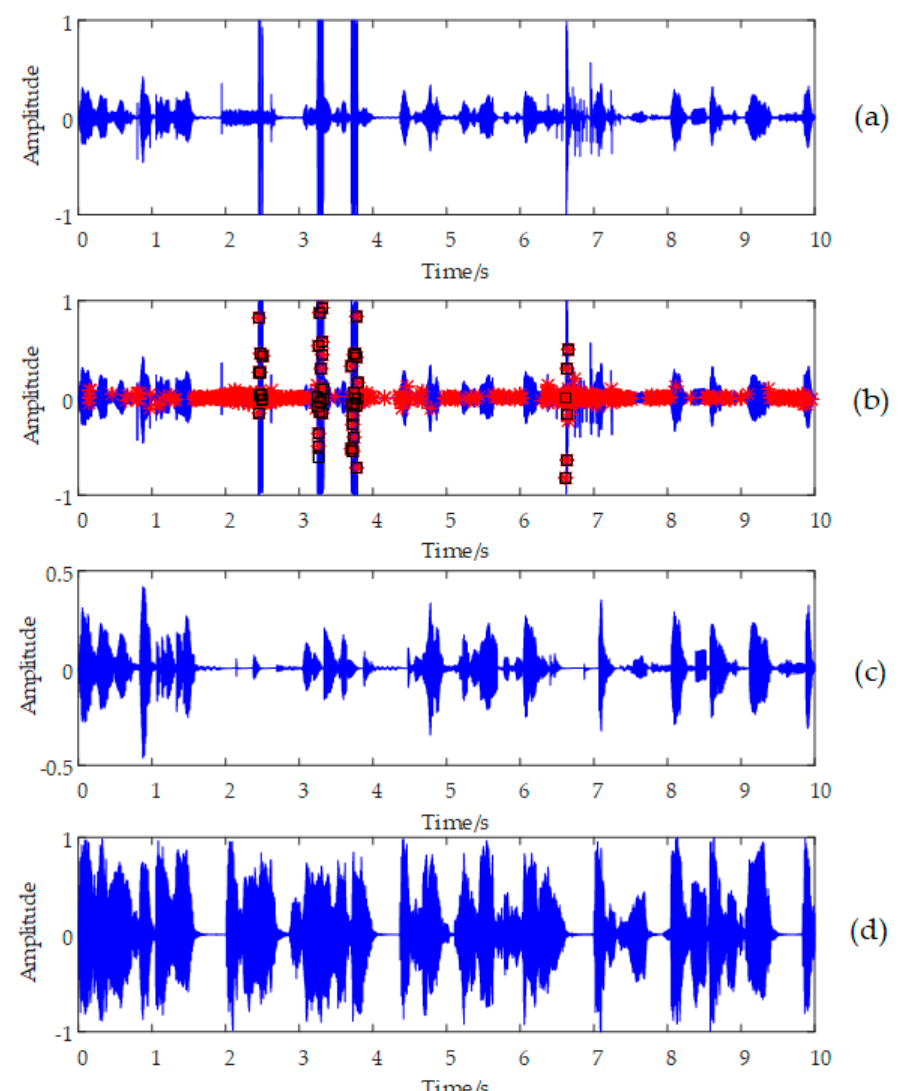
Figure 7. Laser captured speech signal showing ( a ) the raw-detected signal, ( b ) noise locations identified by the proposed method, ( c ) the enhanced-signal, and ( d ) clean signal.